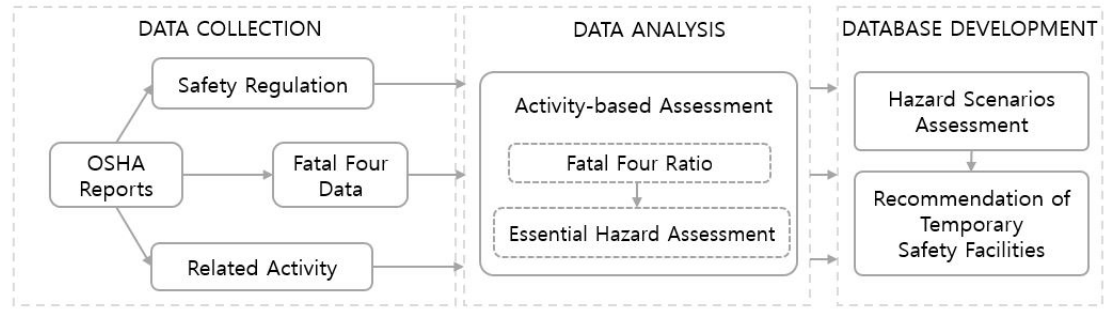
Figure 3. Fatal Four assessment (FFA)